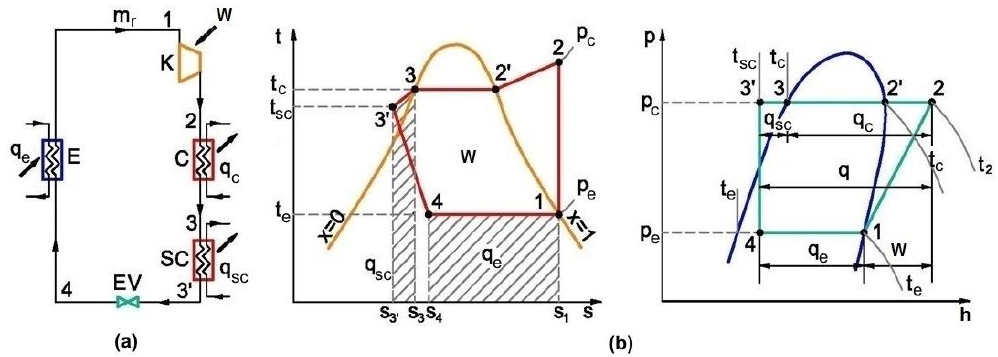
Figure 1. Single-stage heat pump (HP) system: ( a ) Schematic; ( b ) Vapour-compression processes in t - s and p - h diagrams.